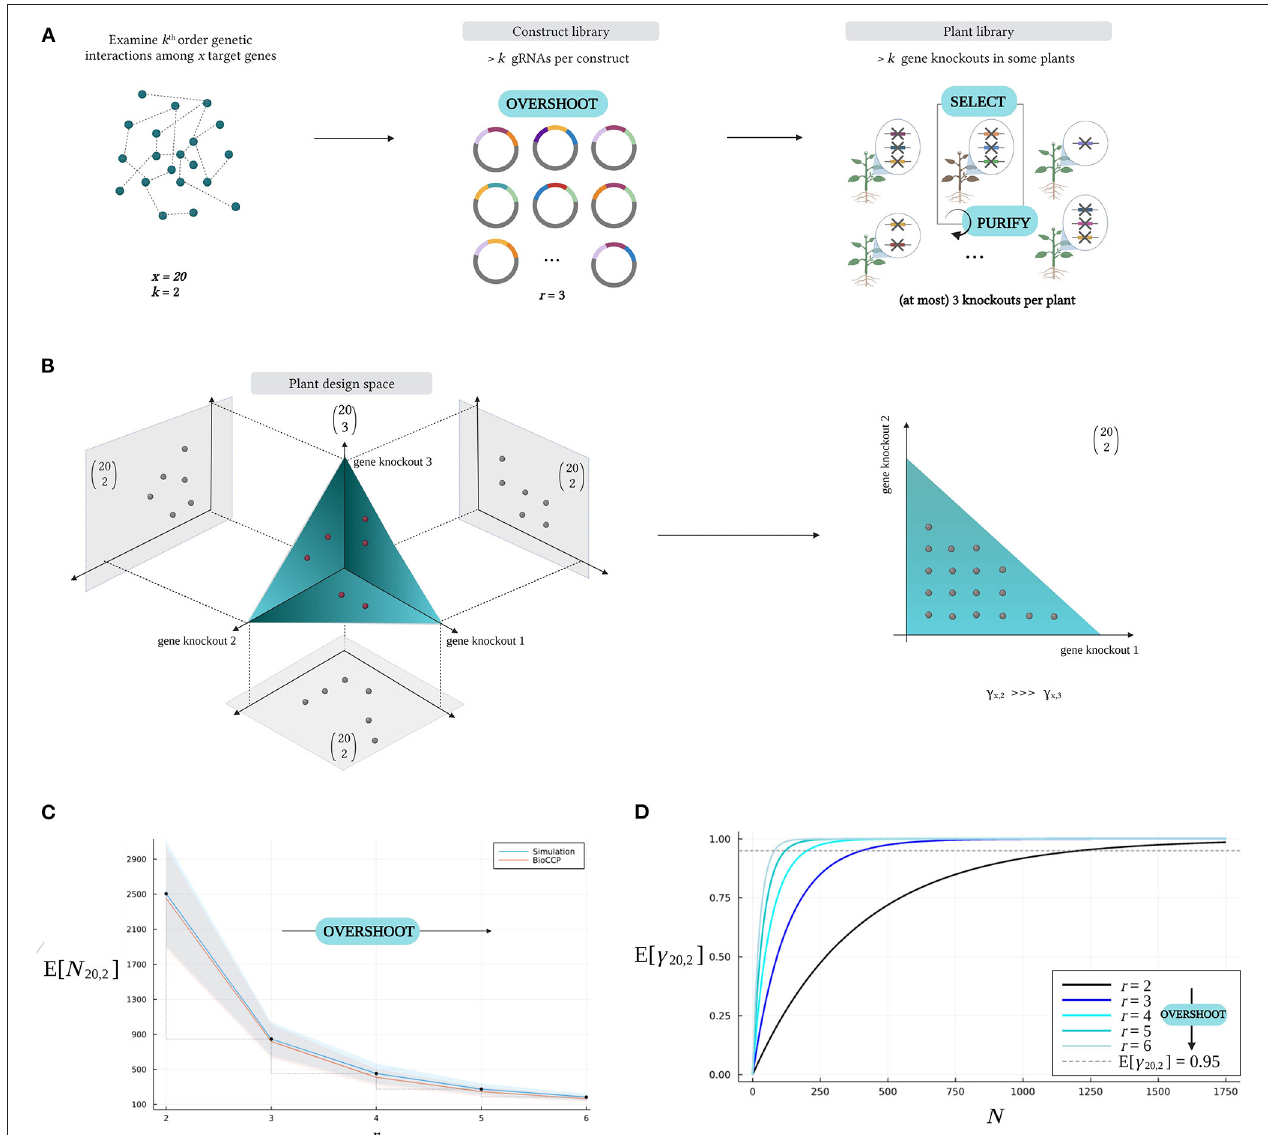
FIGURE 8 | The Overshoot–Select–Purify strategy. (A) For a multiplex CRISPR/Cas experiment investigating all k -combinations of gene knockouts for x target genes, Overshoot–Select–Purify starts with designing a construct library with more than k gRNA sequences per vector ( Overshoot ). Here, pairwise interactions ( k = 2) are investigated among x = 20 target genes, and r = 3 gRNA sequences are included per vector. The resulting plant library will contain plants with up to three gene knockouts. Interesting plant phenotypes can be collected ( Select ), after which the minimal causative genotype can be purified by Mendelian segregation ( Purify ). (B) Impact of Overshoot on the plant design space. In this example, the plant library includes six plants with each three gene knockouts, which are mapped onto the plant design space (red dots). The bag of three gene knockouts in each of the six plants can be decomposed in three pairwise combinations of gene knockouts (gray dots), resulting in a total of 18 pairwise combinations of gene knockouts. A higher coverage γ 20,2 is reached per plant compared to a standard approach where r = k (yielding at most one pairwise combination per plant). (C) Reduction of N x , k as a result of Overshoot . N 20,2 decreases as a higher number of r gRNAs are included per construct, exploring a larger fraction of all possible pairwise combinations of gene knockouts per plant. (D) Increased coverage γ 20,2 at fixed plant library size N as a result of Overshoot . In these graphs, r is varied, while the other parameters were configured with the default settings in Table 2 .